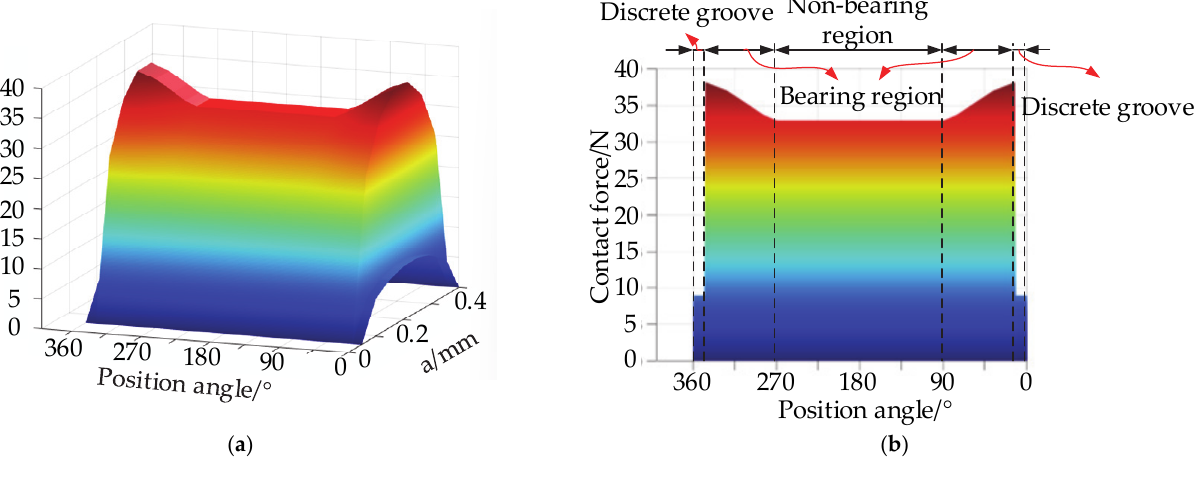
Figure 11. Internal force distribution pattern of raceway particles: ( a ) three-dimensional diagram; ( b ) main view.